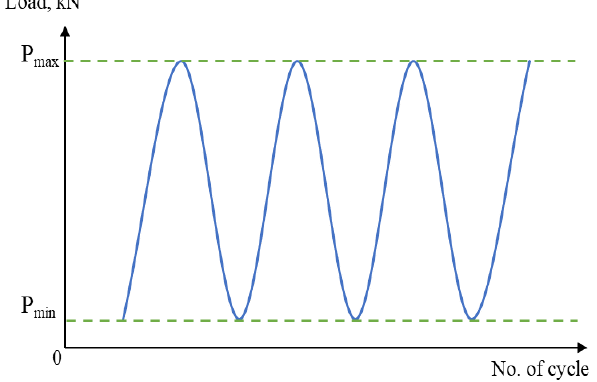
Figure 6. Constant amplitude loading schematic design for the cyclic test. Table 2. Load design for the cyclic test based on UTS percentage.